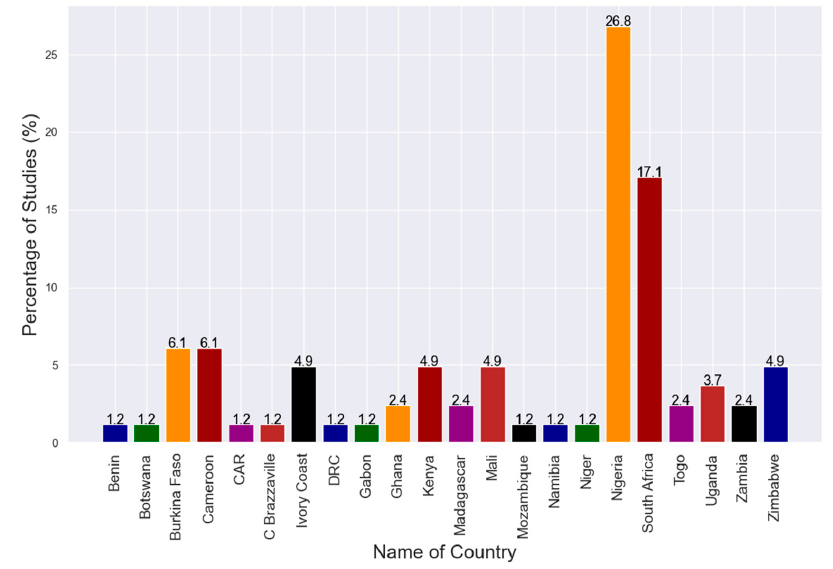
Figure 4. Reviewed articles according to countries. Table 1. Prevalence of avian influenza virus (AIV) in sub-Saharan Africa.